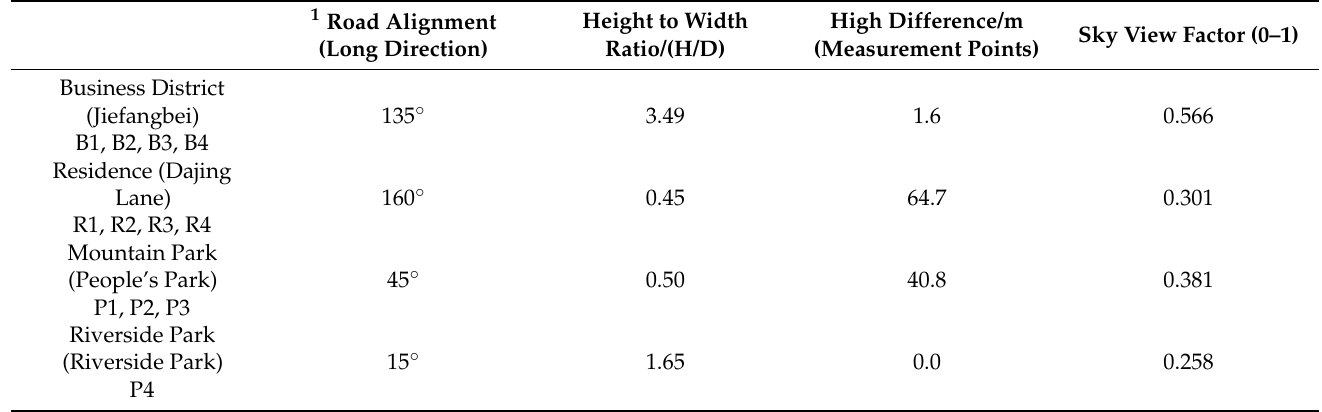
Figure 2. Distribution of measurement points. Table 1. Basic information of each measurement